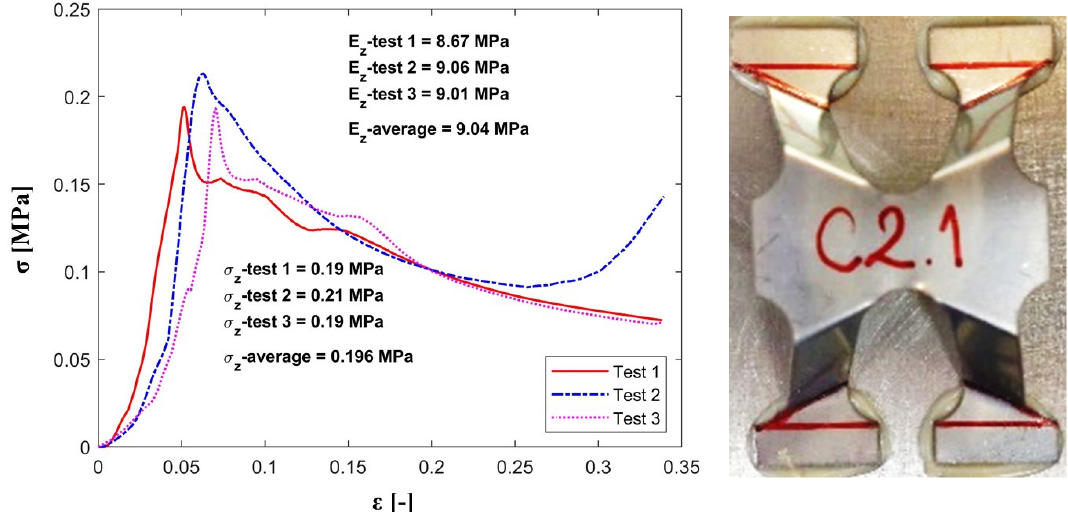
Figure 6. Stress-strain plot for the C1 configuration under out-of-plane compression.